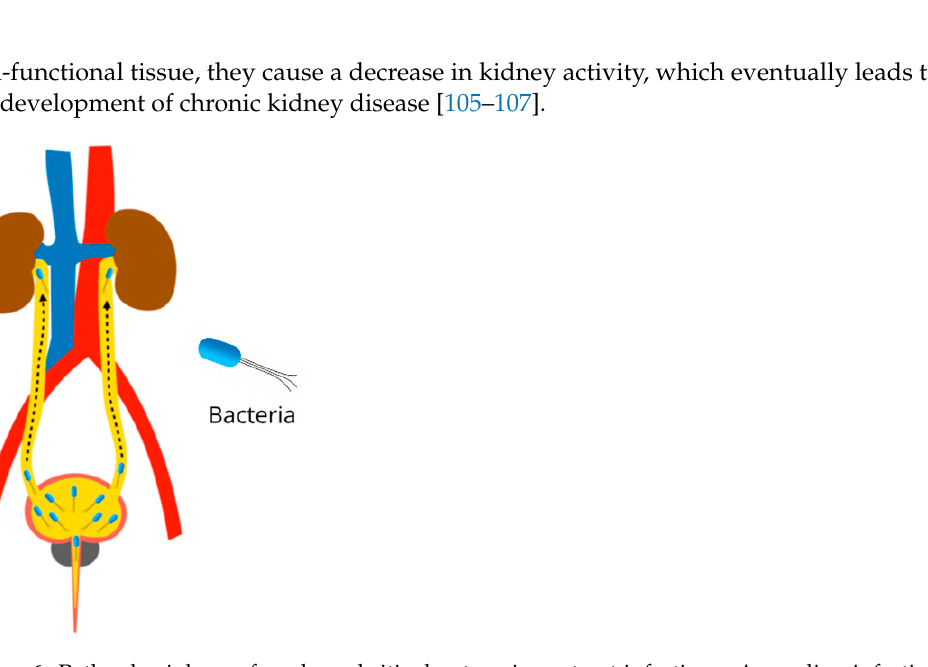
Figure 6. Pathophysiology of pyelonephritis due to urinary tract infections. Ascending infection from the bladder to the kidneys.